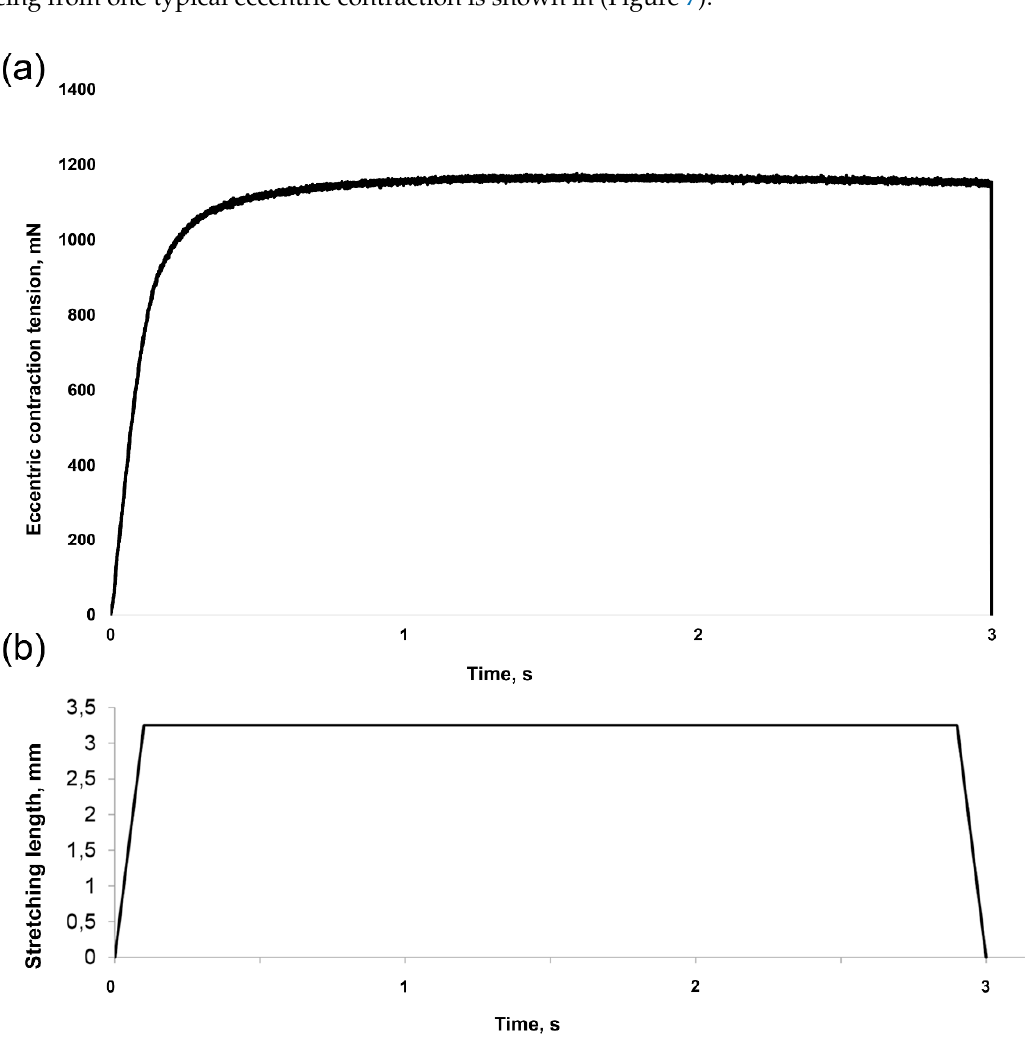
Figure 7. Representative force and muscle length tracing from one typical eccentric contraction. ( a ): changing in muscle force. ( b ): changing in muscle length.